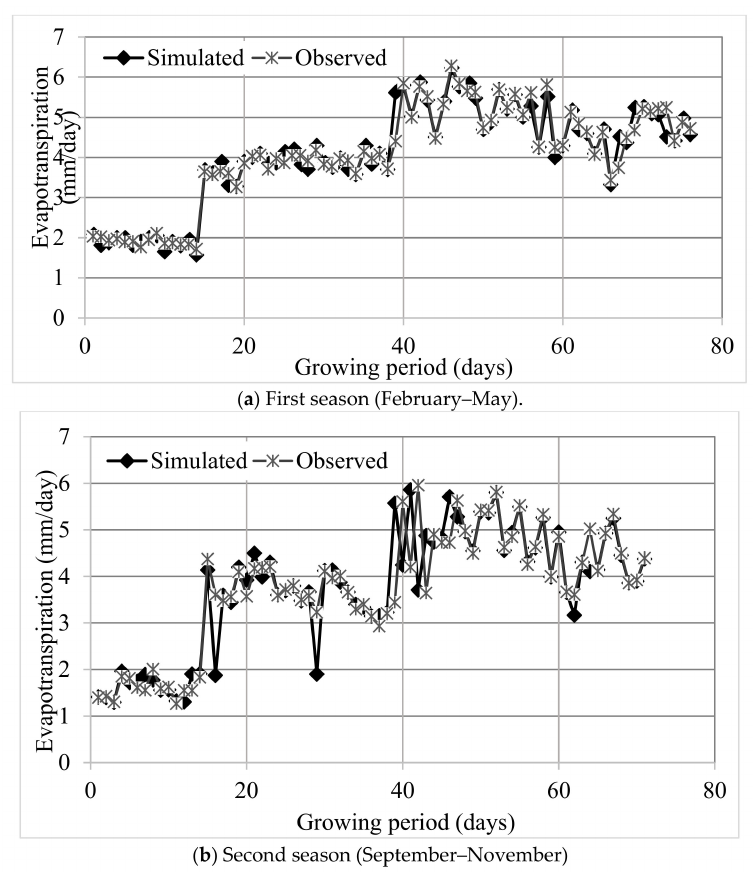
Simulated and observed daily crop evapotranspiration for sweet corn during two growing